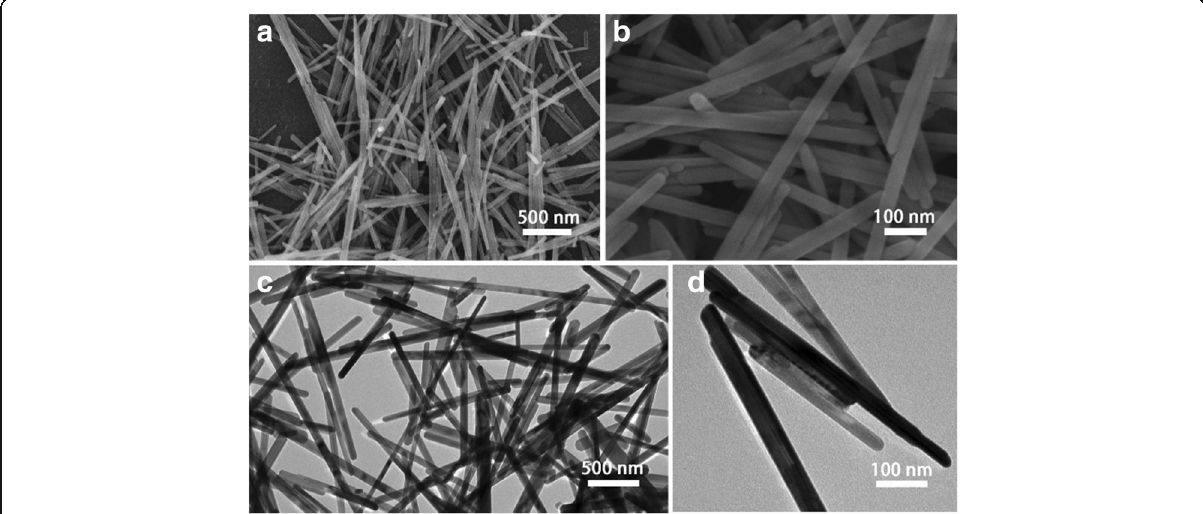
Fig. 2 a , b SEM and c , d TEM images of the CGO